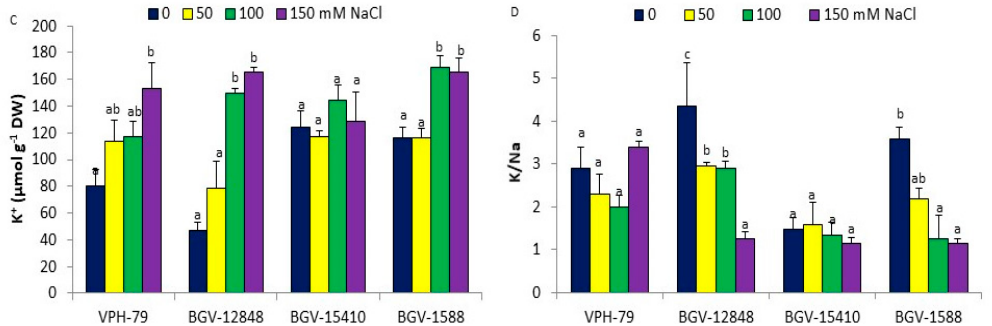
Figure 1. Leaf concentrations ( µ mol g − 1 DW) of monovalent ions, Na + ( A ), Cl - ( B ), K + ( C ), and K + /Na + ratios ( D ), in plants of the four Phaseolus lunatus cultivars, grown for three weeks in the presence of the indicated NaCl concentrations. Means followed by SE ( n = 5). Different letters indicate significant differences within each cultivar according to Tukey’s test ( α = 0.05).